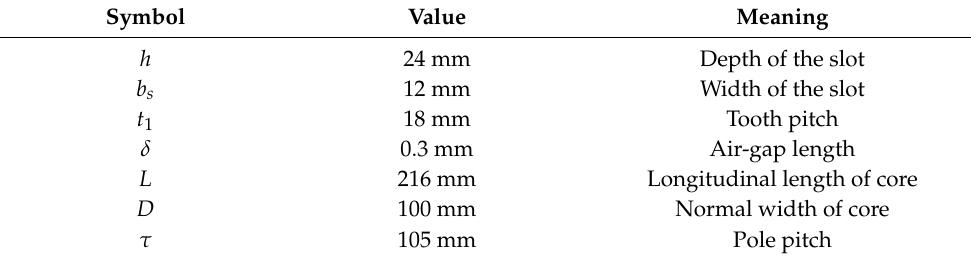
Table 3. Parameters of the UP-LPST.